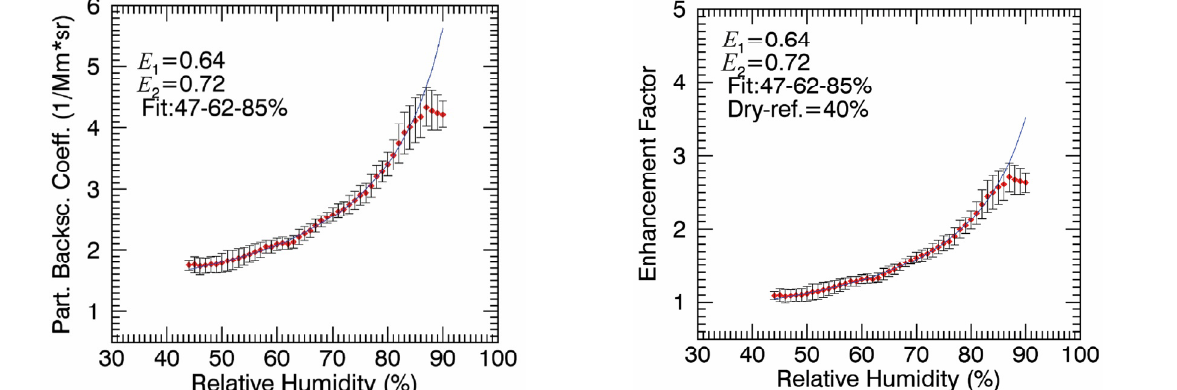
Fig. 2. Enhancement factor in dependence on relative humidity, 13 August